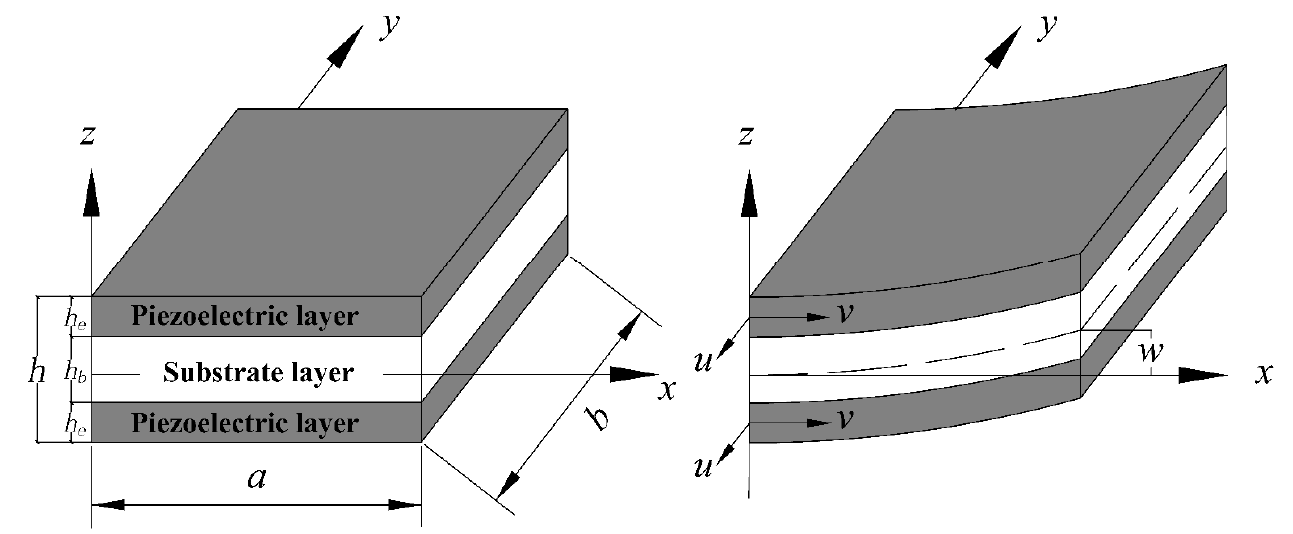
Figure 2. Piezoelectric laminated plate: Before and after deformation. The rectangular coordinate system is constructed with the middle plane of the plate as the xoy plane. For thin plates, using the classical laminated plate theory the strain– displacement relationships at an arbitrary point ( x , y , z ) of the piezoelectric laminated plate are given by